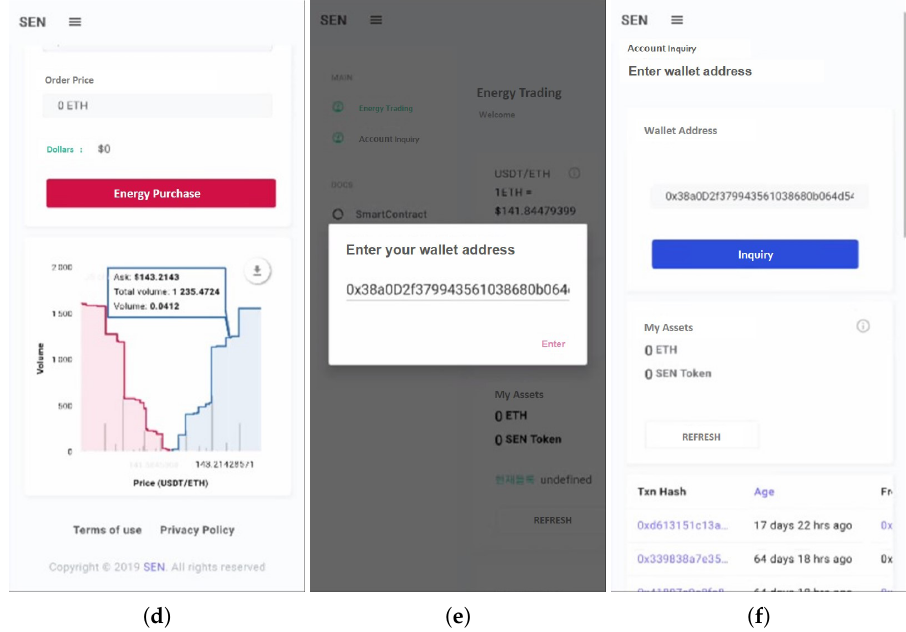
Figure 8. Provided information in mobile application. ( a ) Main page; ( b ) Contract address; ( c ) Market price; ( d ) Price with volume; ( e ) Account lookup; ( f ) Transaction history.